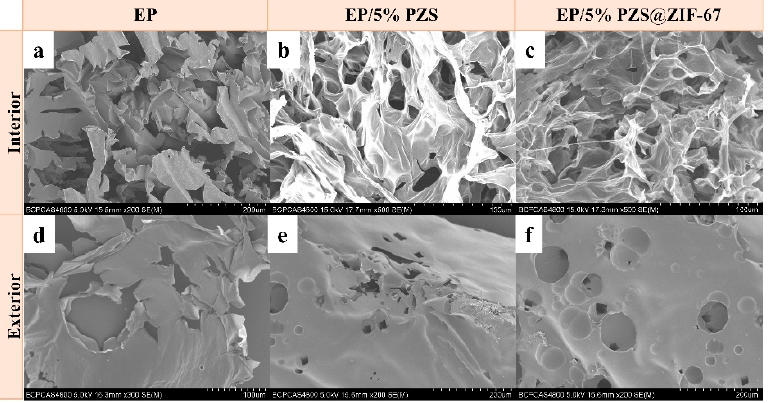
Figure 9. ( a , d ) SEM images of char from EP, ( b , e ) SEM images of interior and exterior char from EP/5% PZS, ( c , f ) SEM images of interior and exterior char from EP/5% PZS@ZIF-67, respectively.